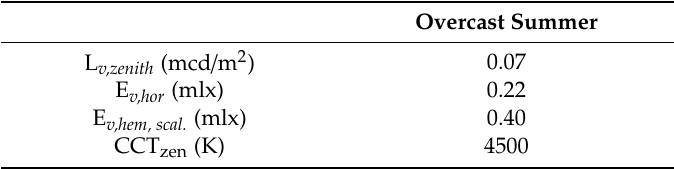
Table 3. List of parameters measured at zenith at the dark reference site in Latvia during a summer night under fully overcast conditions.